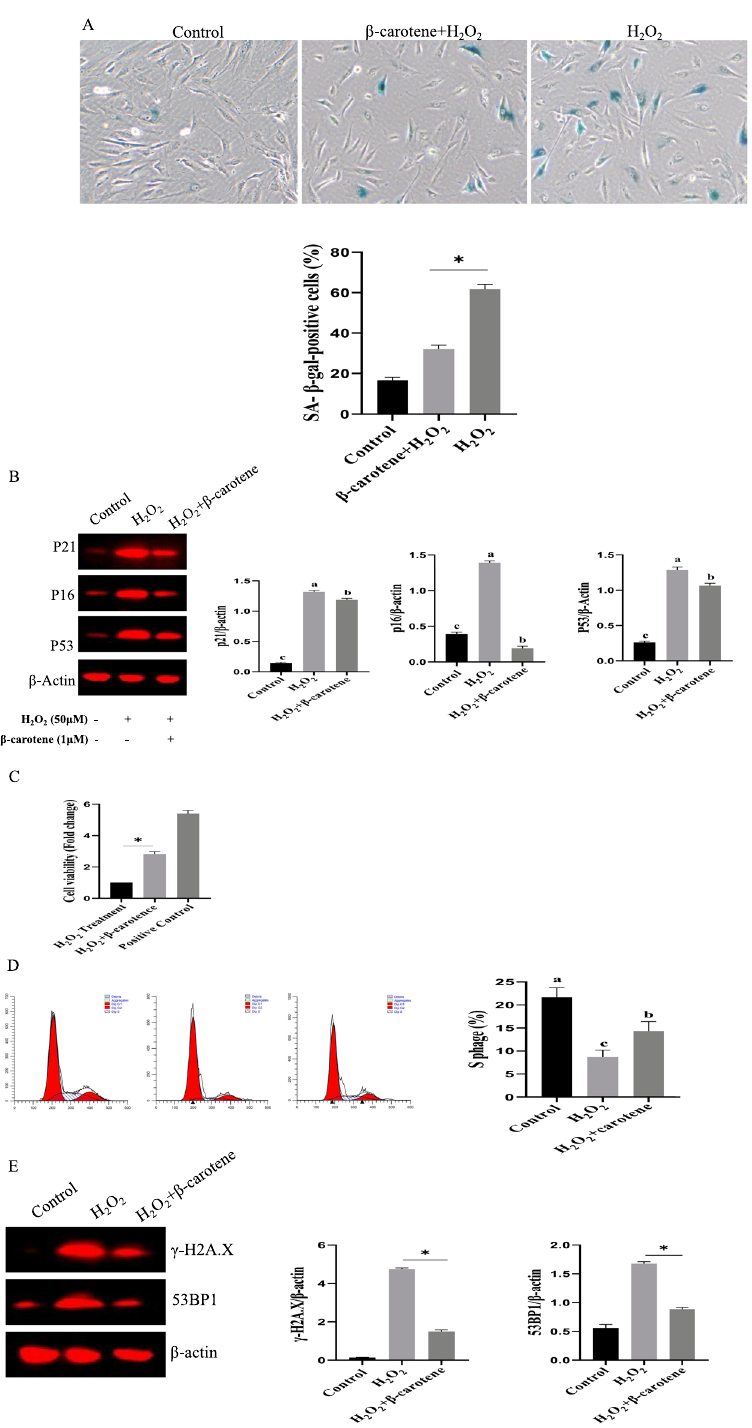
Fig. 4 A β-carotene alleviated the aging of Bm-MSCs. A Sa-β-gal positive cells were decreased under β-carotene treatment. n 5 biological replicates. B The expression levels of p16/p21/p53 was reduced = under β-carotene treatment. C Bm-MSCs proliferation was increased under β-carotene treatment. n biological replicates. D Cell cycle was changed by β-carotene treatment. E β-carotene treatment reduced the expression of γ-H2A.X and 53BP1